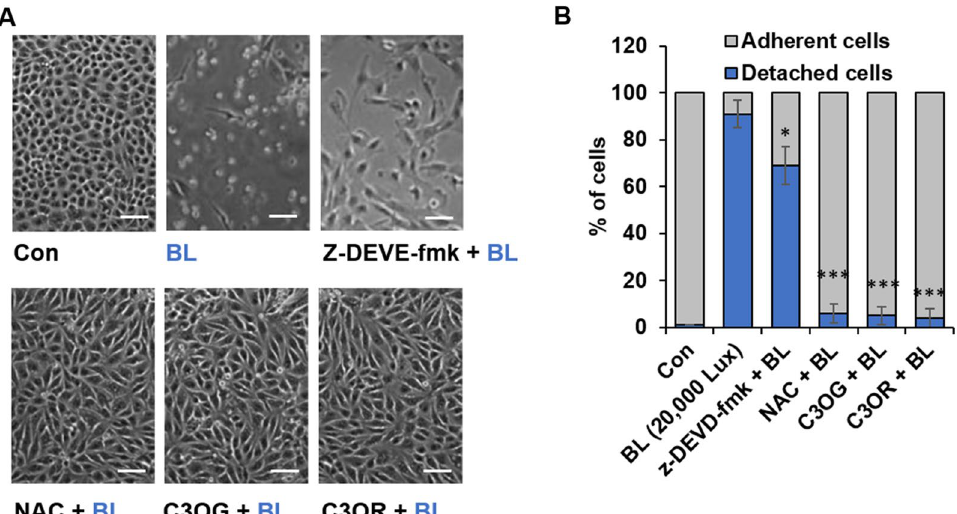
Fig. 6 Effects of C3OG and C3OR on blue light‑induced cell detachment. HaCaT cells in six‑well plates were exposed to blue light for 1 h and then treated with or without NAC (10 mM) or z‑DEVD‑fmk (200 µM) for 24 h. Cells were pre‑treated with C3OG (200 µM) or C3OR (200 µM) for 24 h prior to blue light exposure ( A , B ). Representative phase‑contrast images are shown ( A ), and the percentages of cell adhesion and detachment relative to the control ( B ) were quantified ( n